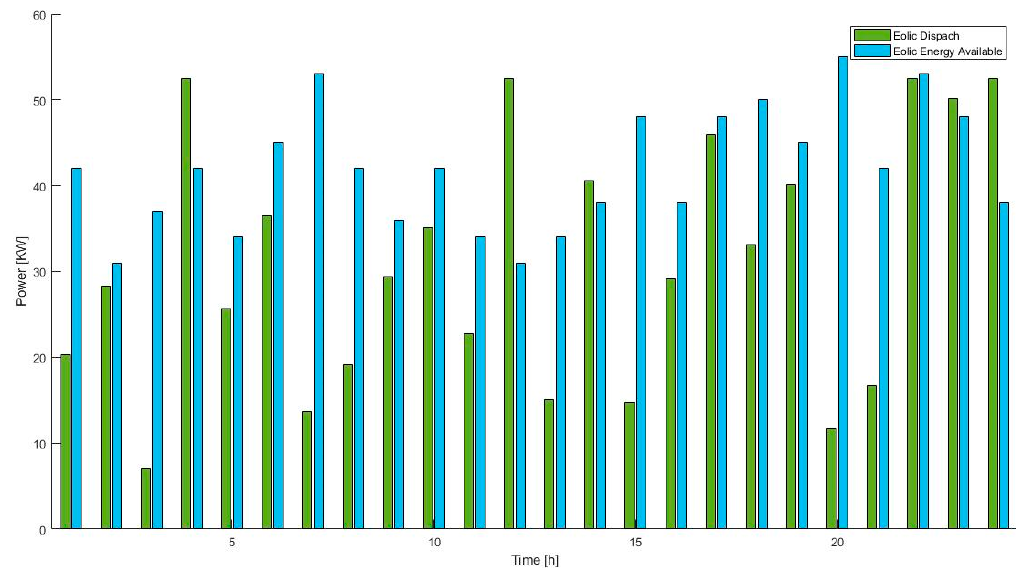
Figure 11. Availability and dispatch of the wind energy system of the MG when the storage system is at 60% of its useful life.